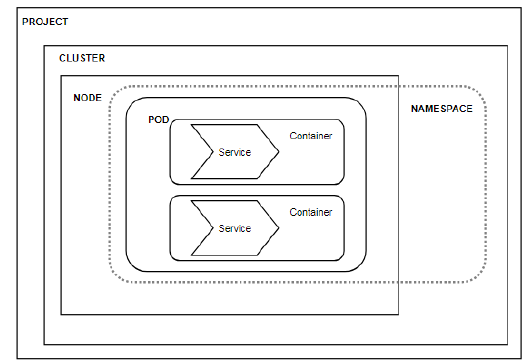
Figure 2. Encapsulation of Microservices inside the Container [12]